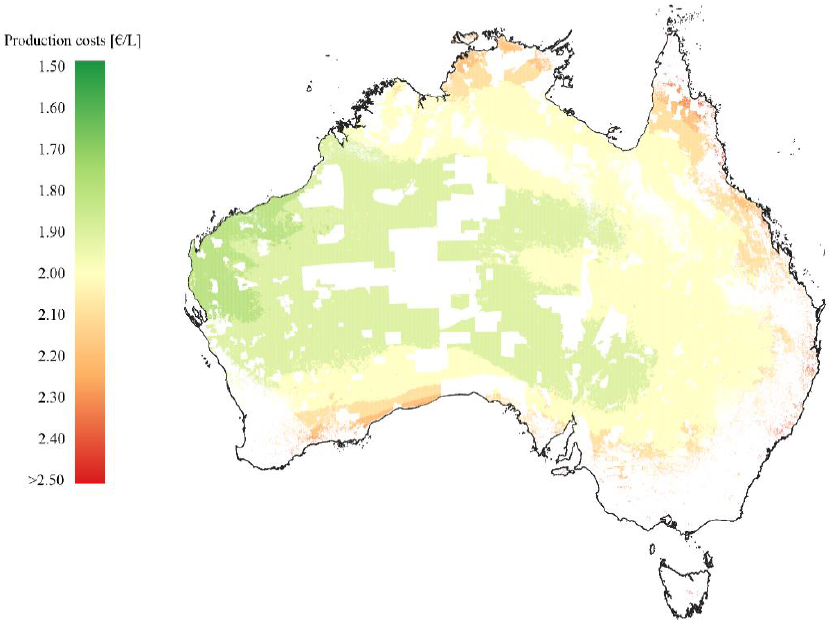
Figure A8. Production costs of solar thermochemical jet fuel in Australia.